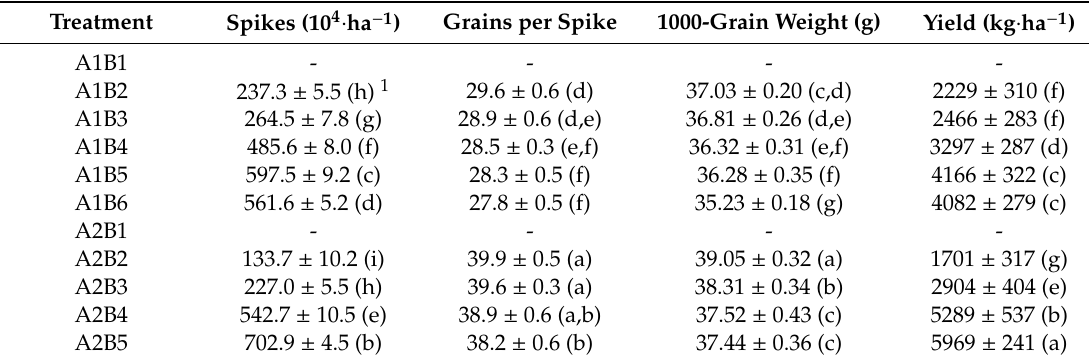
Table 11. Wheat yield and yield components for di ff erent sowing dates